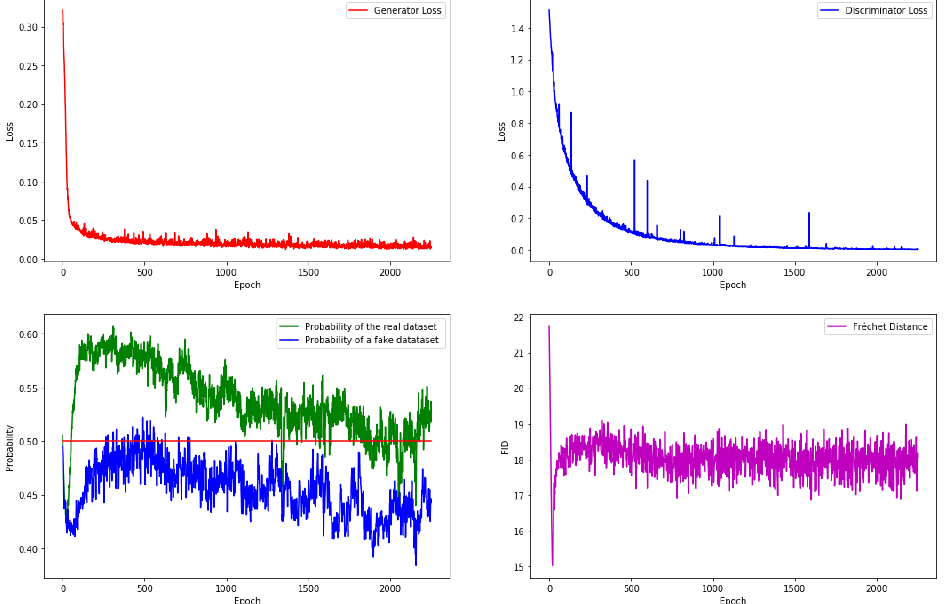
Figure 7. Training results for the implemented GAN architecture. Losses (upper part), Accuracy on real and synthetic data (lower left), and Fréchet distance (lower right) are depicted.